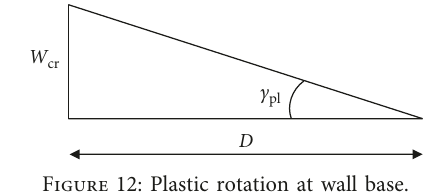
Figure 12: Plastic rotation at wall base.